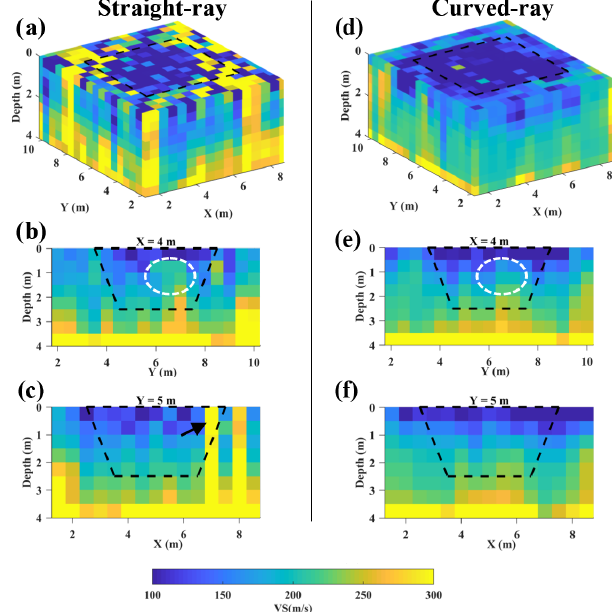
Figure 13. The VS models from SWT inversion. The boundaries of the sand body are superimposed in black dashes. The results of the straight-ray SWT inversion are shown as (a) the 3D view of the VS model, (b) the vertical slice at X = 4m, (c) at Y = 5m, and the corresponding results from the curved-ray SWT inversion are displayed in panels (d) – (f)